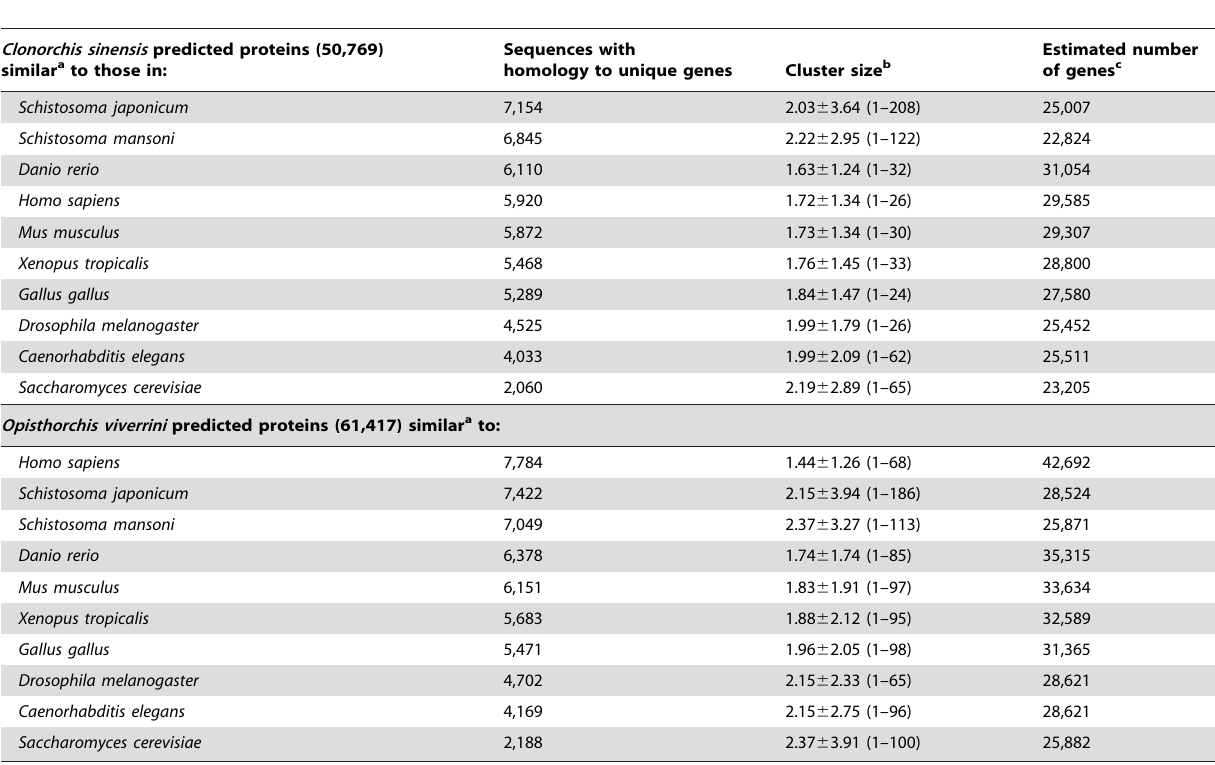
Table 5. Summary of the numbers of unique genes predicted to be expressed by the adult stage of each Clonorchis sinensis and Opisthorchis viverrini based on amino acid sequence similarity to model eukaryotic organisms.